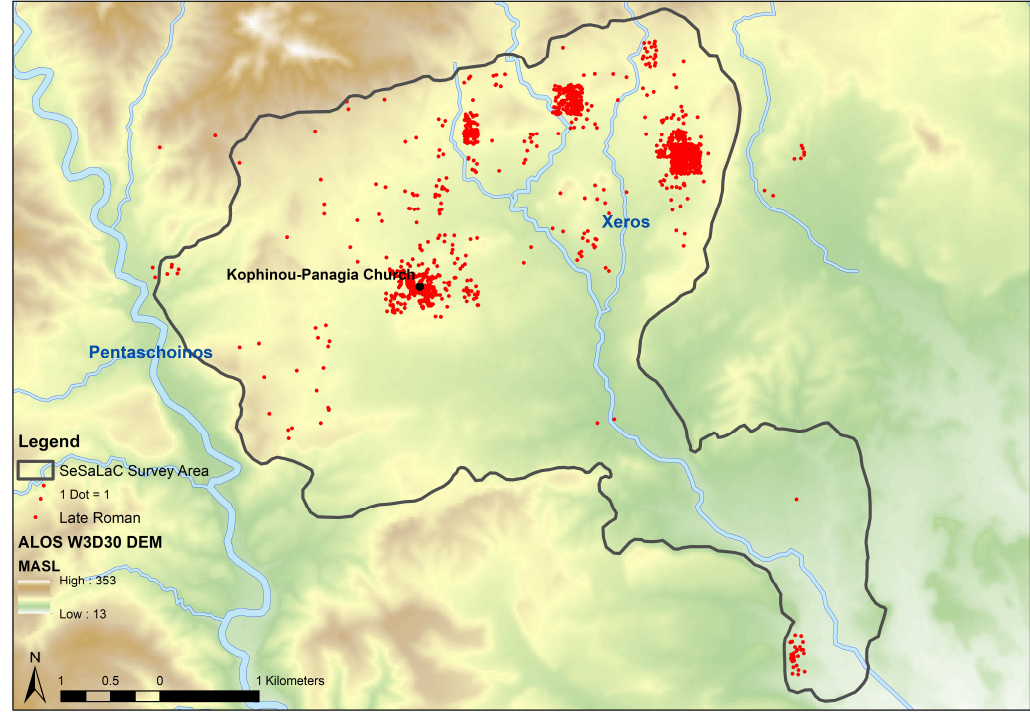
Figure 22. Late Antique (Late Roman) pottery distribution. Digital data courtesy of the Geological Survey Department, Republic of Cyprus (Map by Charalambos Paraskeva).